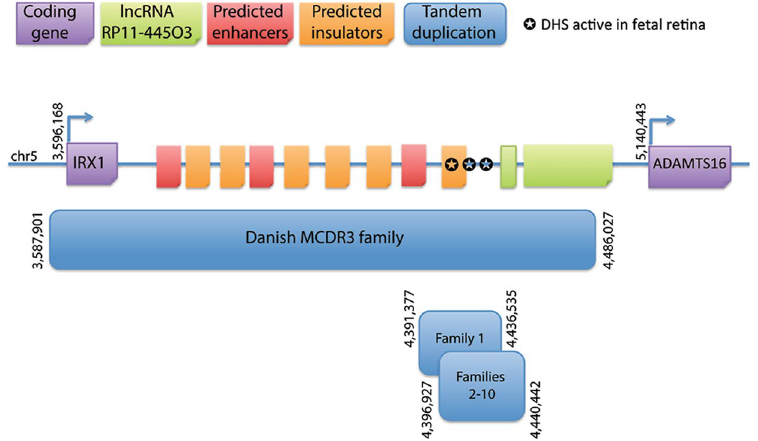
Figure 4. Schematic representation of the MCDR3 locus which is refined to a 39 kb shared genomic region (GRCh37/hg19 chr5:4396925–4436534). The shared sequence between a previously reported duplication and the two novel SVs identified in this study is located in a large gene desert, downstream of IRX1 and upstream of ADAMTS16 , 800 kb and 693.9 kb from their respective transcription start sites. Publicly available NGS datasets were queried for informative data on chromatin accessibility and 3 sites were found active from human gestation day 72 to 105 in fetal retina, suggestive of functional acting elements within this